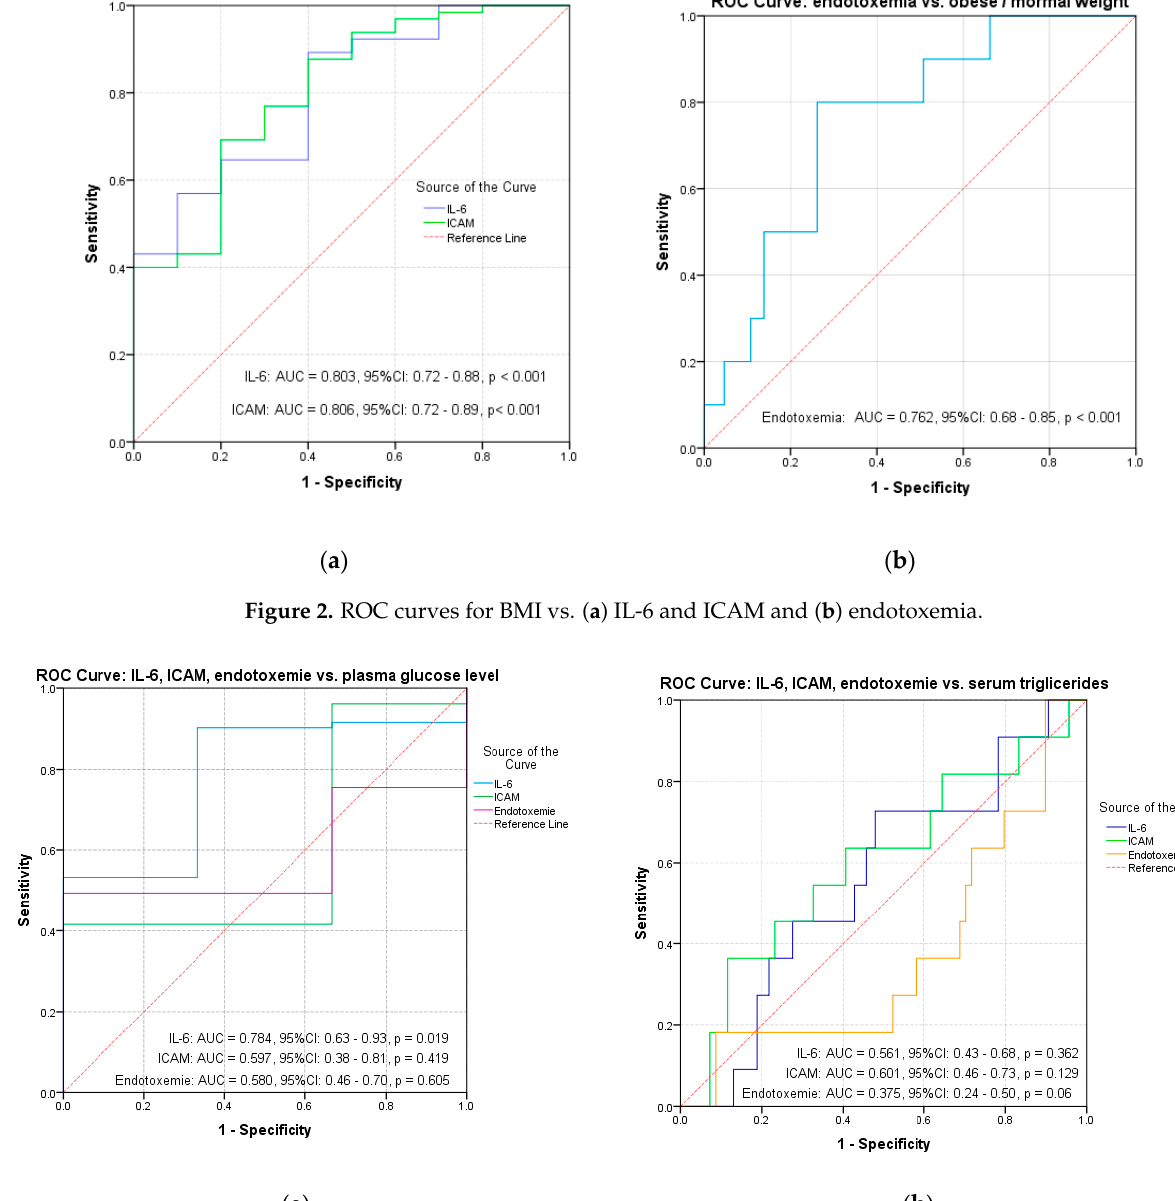
( b ) Data: Endotoxemia vs. obese / normal weight Endotoxemie-obese Endotoxemie-normal weight T e s t V a l ue E ndo t o x e m i e 3.43.53.6 3.7 3.83.94.04.1 4.2 Cutoff < 3.95 Sens = 0.74 Spec = 0.83 ( c )